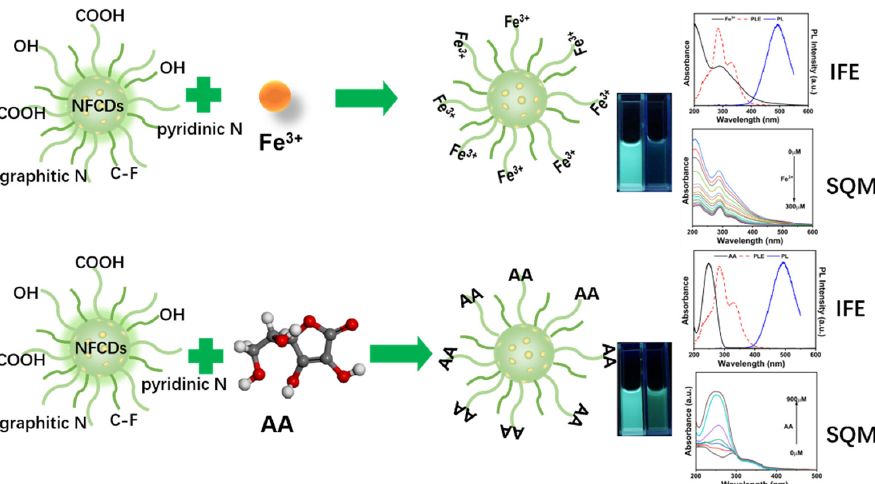
Figure 7. Possible quenching mechanism of NFCDs of Fe 3+ and AA: ( Top ) the addition of Fe 3+ with different concentrations interacts with the surface functional groups to form a non-fluorescent complex (SQM); UV-vis spectra show overlaps from 280 to 330 nm between UV absorption (black line) and PLE of NFCDs (red line). ( Bottom ) the addition of AA interacts with the surface functional groups to form a non-fluorescent complex (SQM); UV-vis spectra show overlaps from 200 to 300 nm between UV absorption (black line) and PLE of NFCDs (red line).